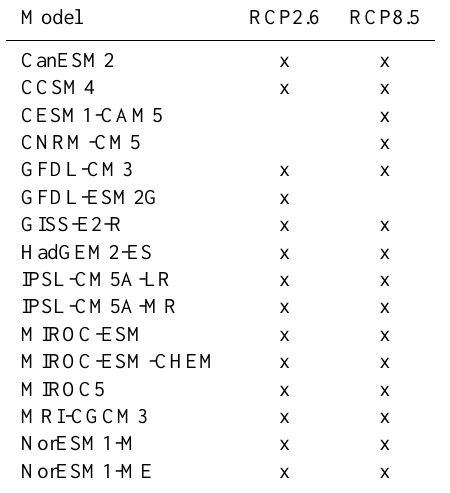
Table 3. CMIP5 models and RCPs used ( x ) in calculations of 2071– 2100 snowfall. Model